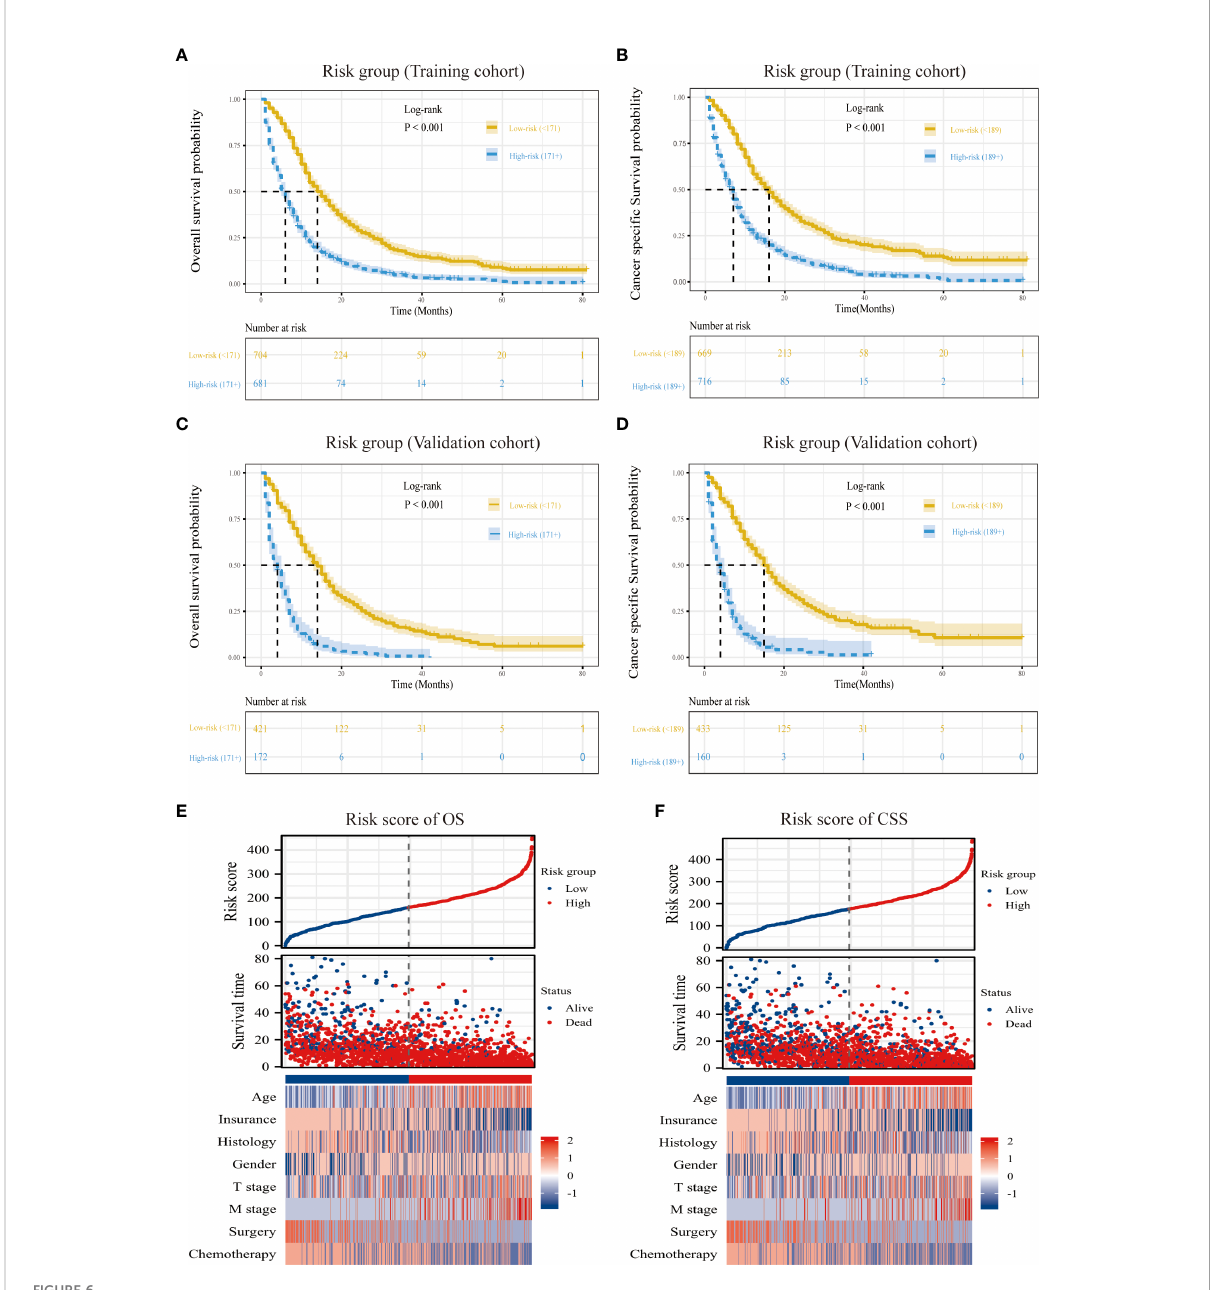
FIGURE 6 Overview of risk-strati fi cation system according to risk points calculated by nomogram. OS and CSS analysis of patients with MPM in the training cohort (A, C) and validation cohort (B, D) . The distribution of clinicopathological features in different risk groups for OS (E) and CSS (F)